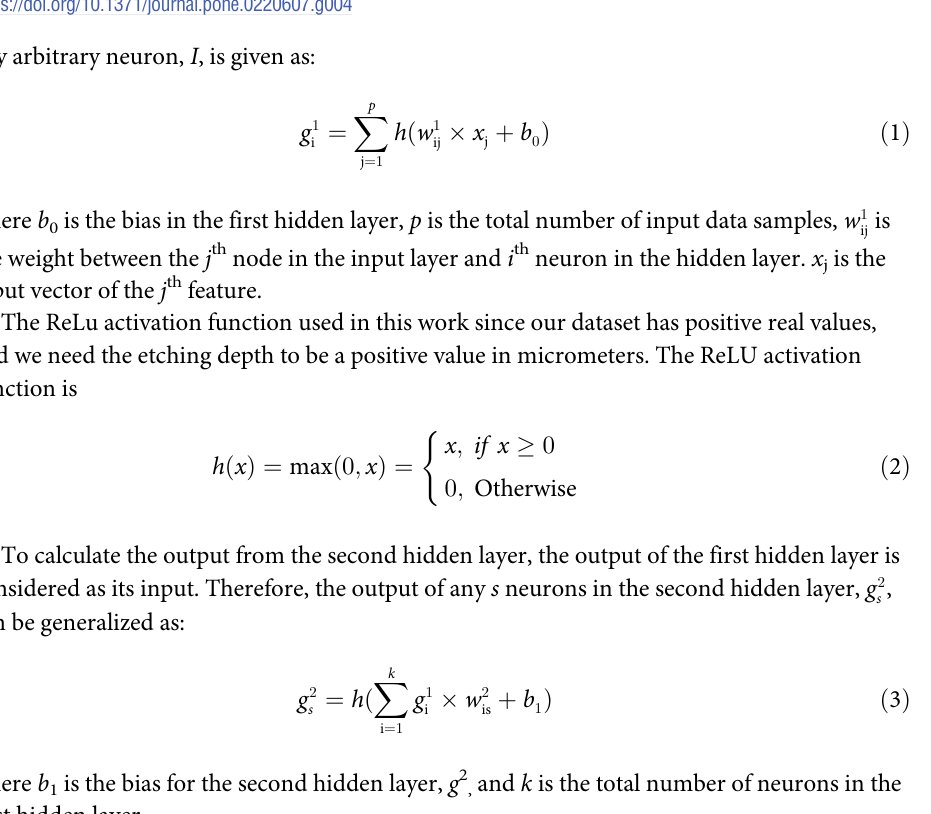
Fig 4. General structure of a four-layer NN with 2 input features, two hidden layers with 50 neurons in each layer, and one output layer.